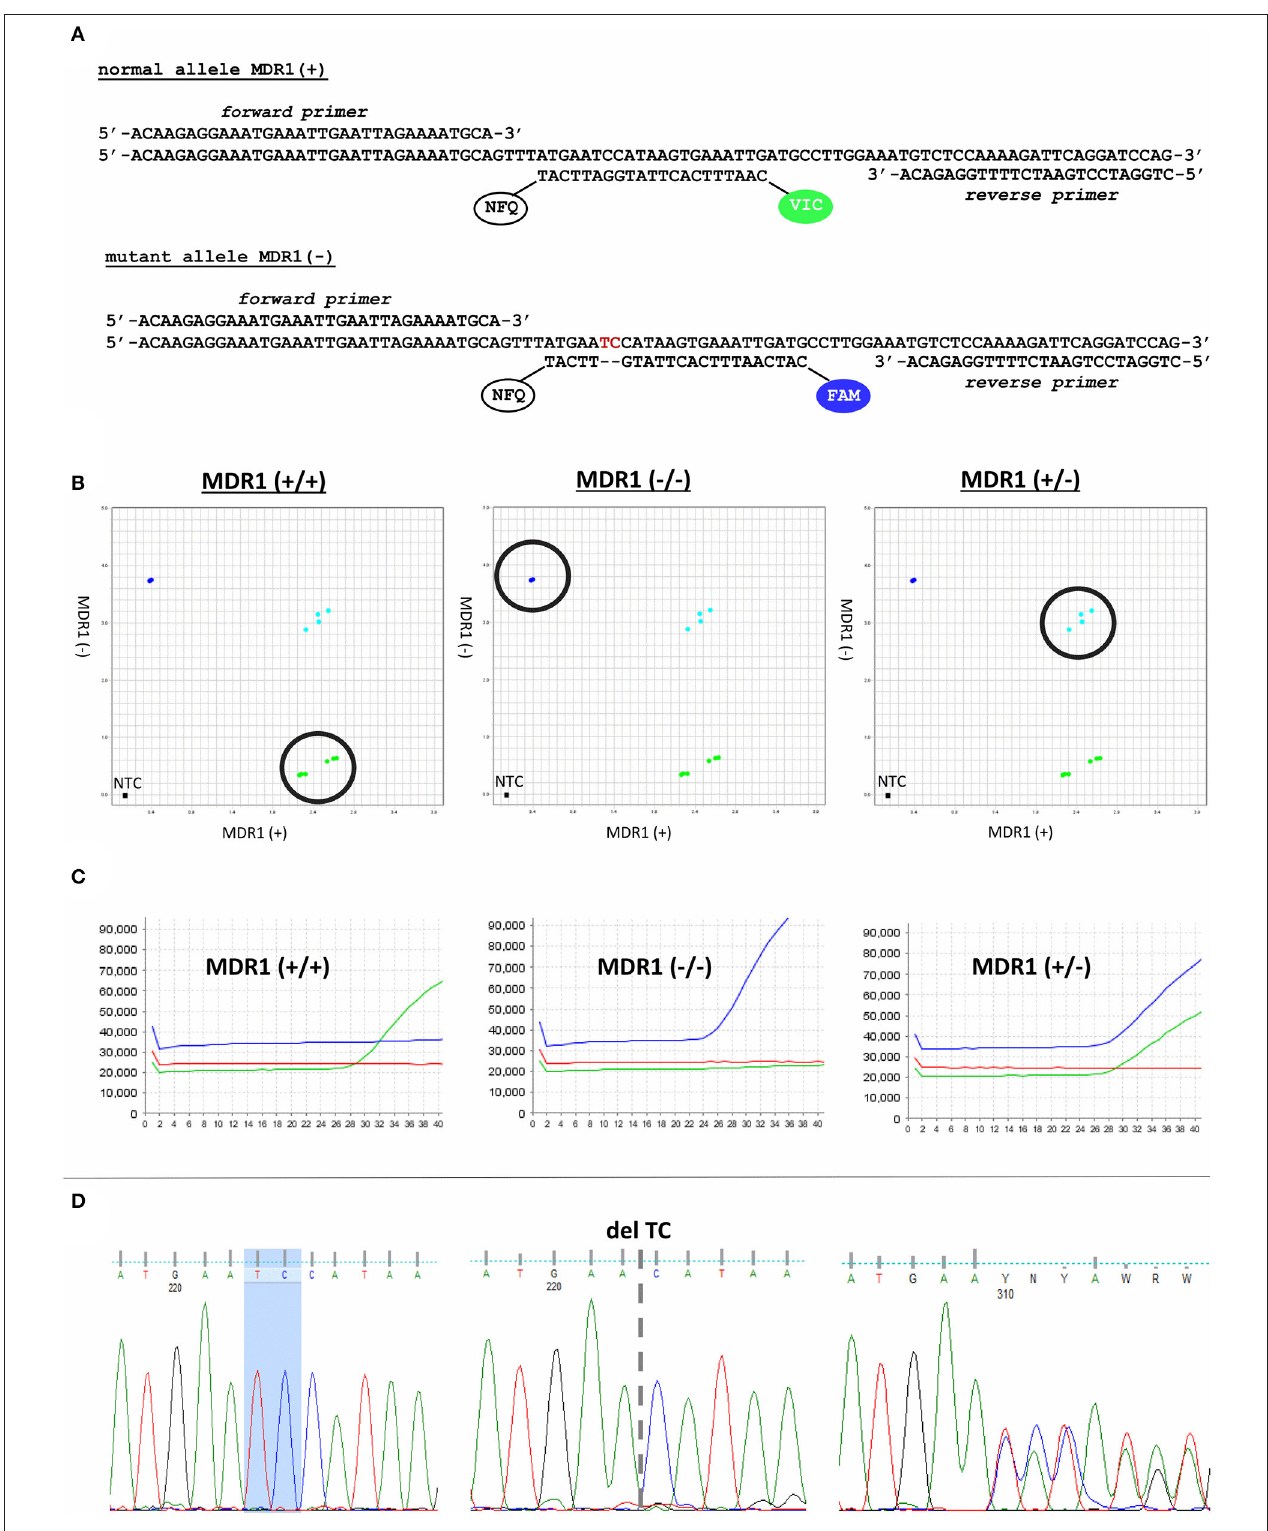
FIGURE 2 | Cat MDR1 genotyping. (A) Gene-specific primers and allele-specific probes of the TaqMan AD assay. (B) AD plot revealed discrete clusters for all three genotypes. (C) Fluorescence readouts from the real-time PCR amplification revealed clear separation between fluorescence signals from the VIC-coupled wild-type probe and the FAM-coupled mutant probe. (D) Verification of the TaqMan AD genotyping calls by Sanger sequencing.